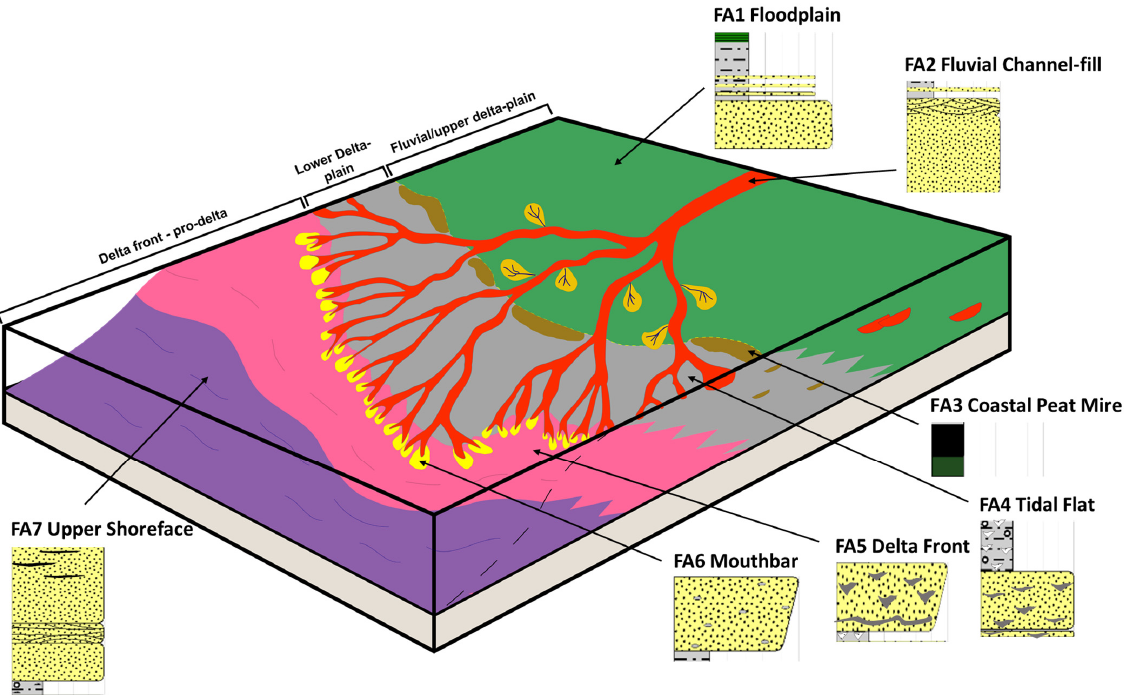
Figure 9. Paleodepositional model for the studied Tanjong Formation with different sub-environ- ments from FA1 to